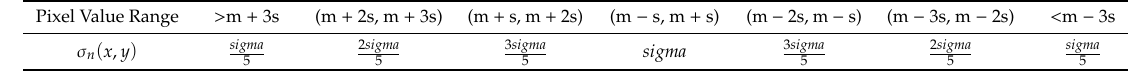
Table 1. Filter selection according to the value range of